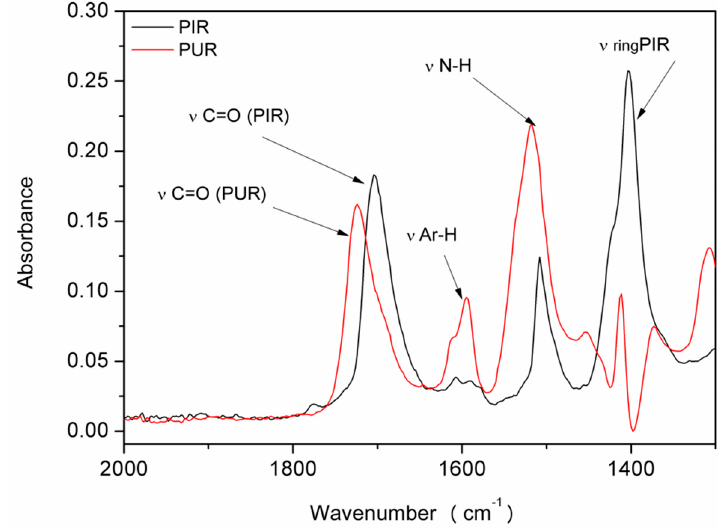
Figure 8. Spectrum of the main factors: PUR and PIR.